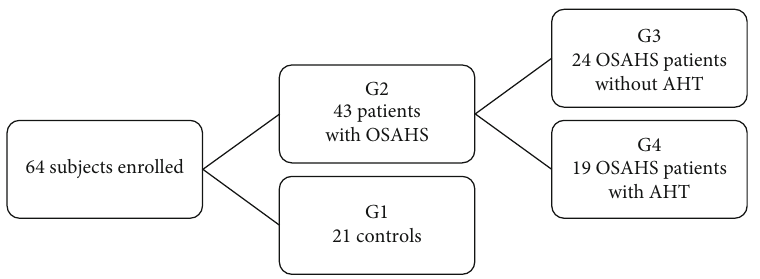
Figure 1: Composition of the study population. G: group; OSAHS: obstructive sleep apnea-hypopnea syndrome. AHT: arterial hypertension. Table 1: General characteristics of the four study